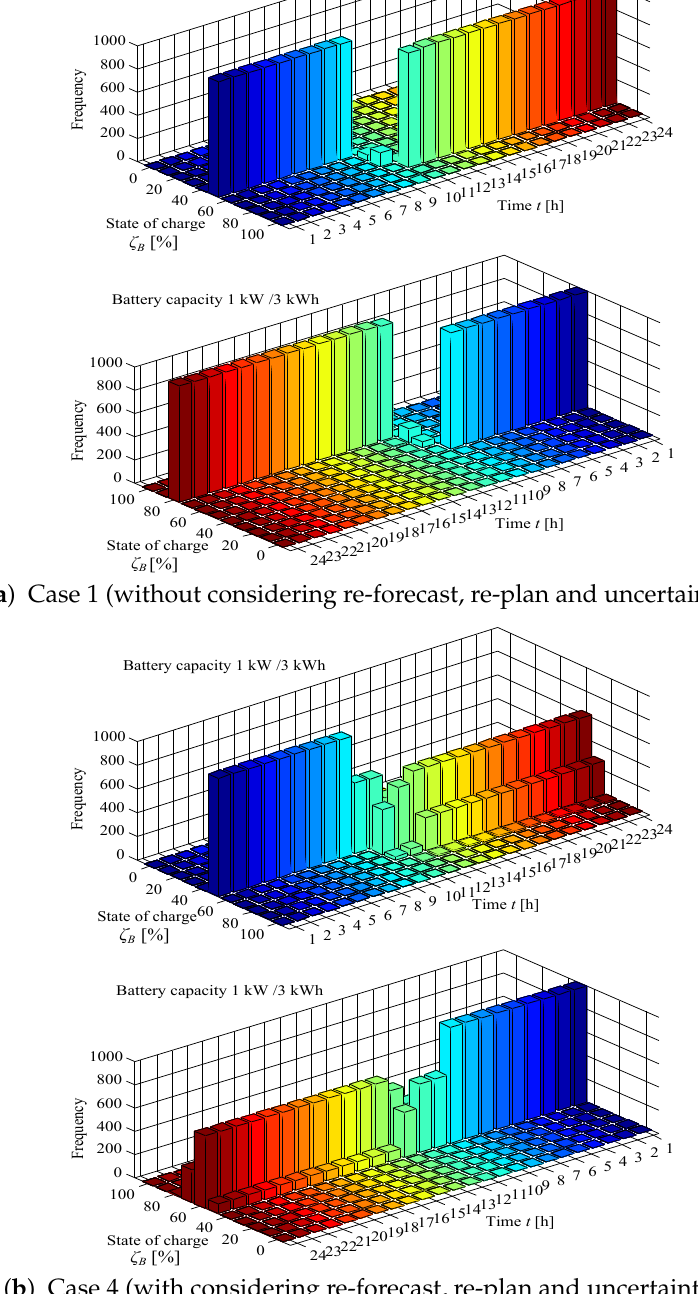
Figure 14. Histogram of state of charge on battery for 1000 scenarios in each